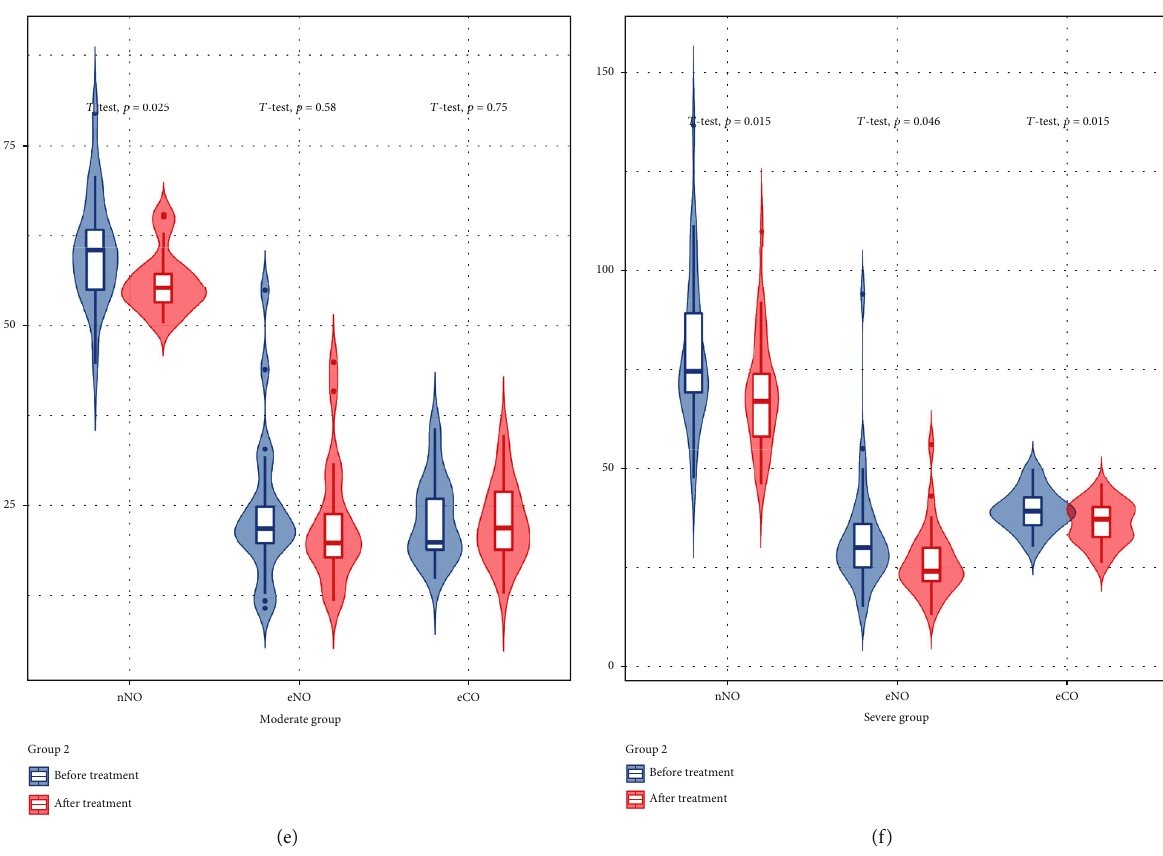
Figure 3: Correlation between nNO, eNO, eCO, and symptom score in AR group. (a) The correlation between nNO level and symptom score, R 2 = 0 : 8 , p = 0 : 01 ; (b, c) although there was a positive correlation between eNO, eCO, and symptom score, the R 2 of the two groups was 0.2 and 0.71. (d) The nNO of allergic rhinitis patients in the three groups was signi fi cantly lower than that before treatment, with statistical signi fi cance; (e, f) although eNO and eCO decreased after treatment, only in severe patients, the changes were statistically signi fi cant.